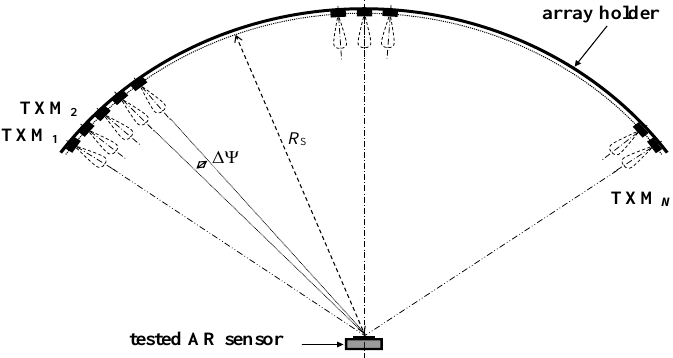
Figure 2. Testing setup based on an array of transmitting modules. The TS receiving antenna is situated anywhere in view of the AR sensor.